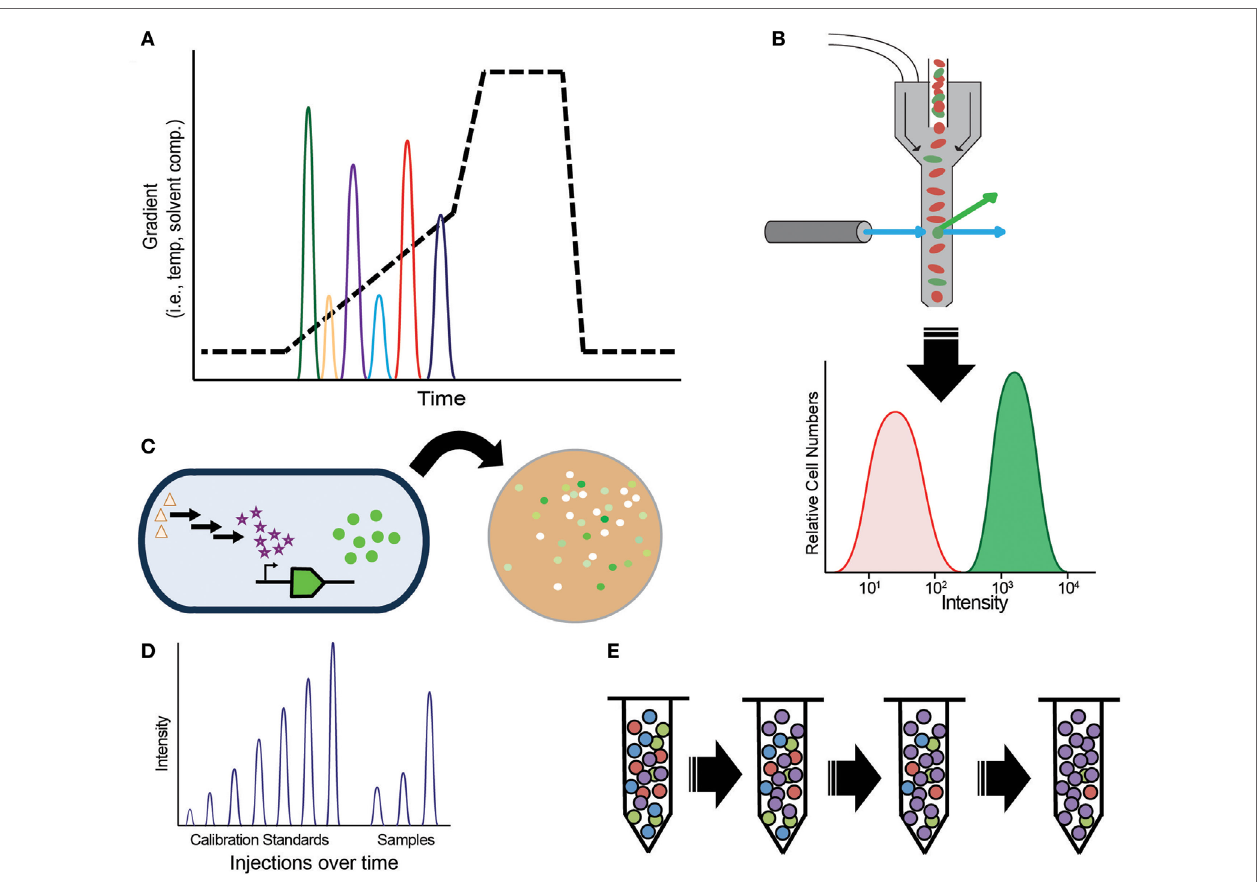
FiGURe 2 | Methods for target molecule measurements, (A) chromatography; (B) spectroscopy-based fluorescent-activated cell sorting (FACS); (C) biosensors; (D) direct injection mass spectrometry; (e) selection-based assays